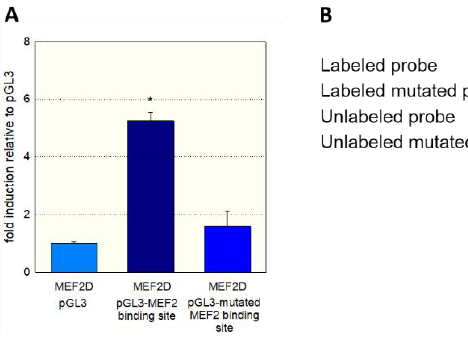
Figure 4. Interaction of MEF2 with the SLC22A5 gene promoter. ( A ) C2C12 myoblasts overexpressing MEF2D were transfected with the non-mutated −1624/−1595 fragment and with the −1624/−1595 fragment containing a T to G mutation in position −1607 of the SLC22A5 gene promoter. The mutation blunted the stimulation of the promoter activity by MEF2D. ( B ) Gel-shift competition and electrophoretic mobility shift (EMSA) assays using the unmutated and mutated labeled regulatory sequence −1624/−1595 proved the interaction of MEF2D with the SLC22A5 gene promoter. Data are presented as the mean ± SD of n = 3 independent observations. * p < 0.05 vs. pGL3.